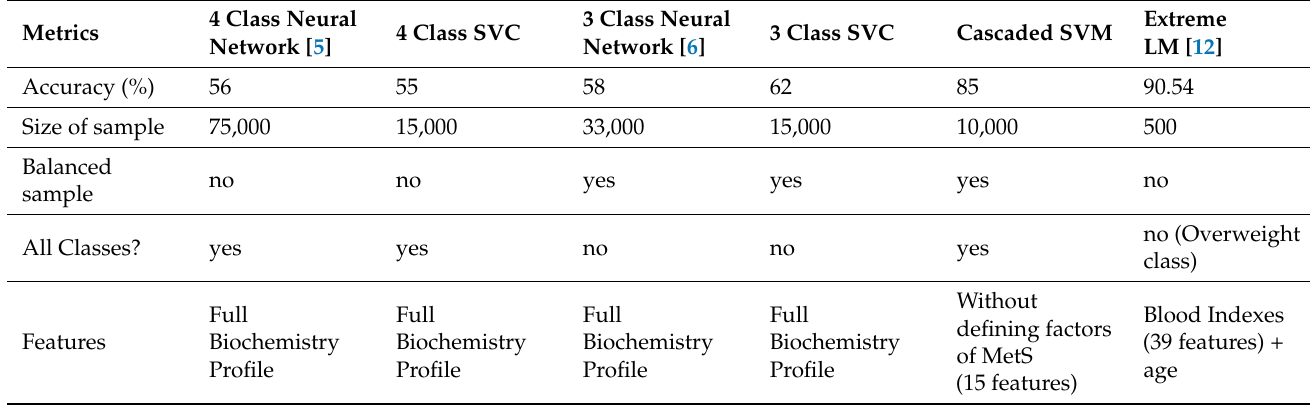
Table 3. Comparison of methodologies—